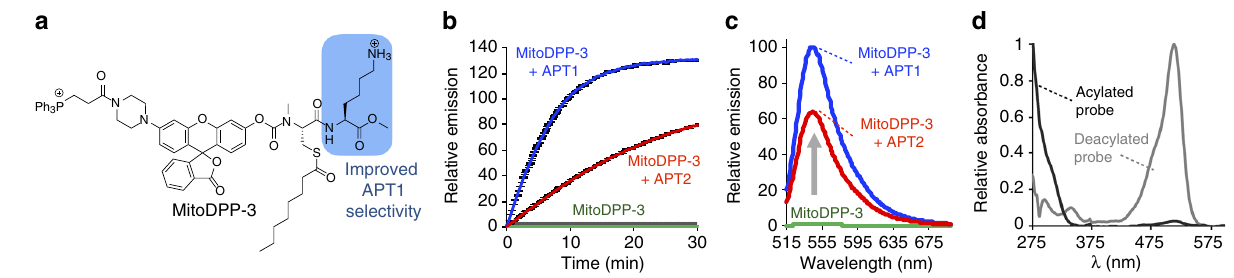
Fig. 5 In vitro activity of mitoDPP-3. a Structure of mitoDPP-3. b In vitro fl uorescence assay of 1 µ M mitoDPP-3 in HEPES (20 mM, pH 7.4, 150 mM NaCl, 0.1% Triton X-100) with either 50 nM puri fi ed APT1 or APT2 ( λ ex 490/20 nm, λ em 545/20 nm). For plots, n = 3, error bars are ± s.e.m. c Fluorescence emission spectra at 30 min from probes as treated in ( b ). d UV – vis spectra of 25 µ M mitoDPP-3 (black; normalized at 275 nm) and deprotected fl uorophore product (gray; normalized at 513 nm) in HEPES (20 mM, pH 7.4, 150 mM NaCl, 0.1% Triton X-100). MitoDPP-3 shows UV – vis absorbance